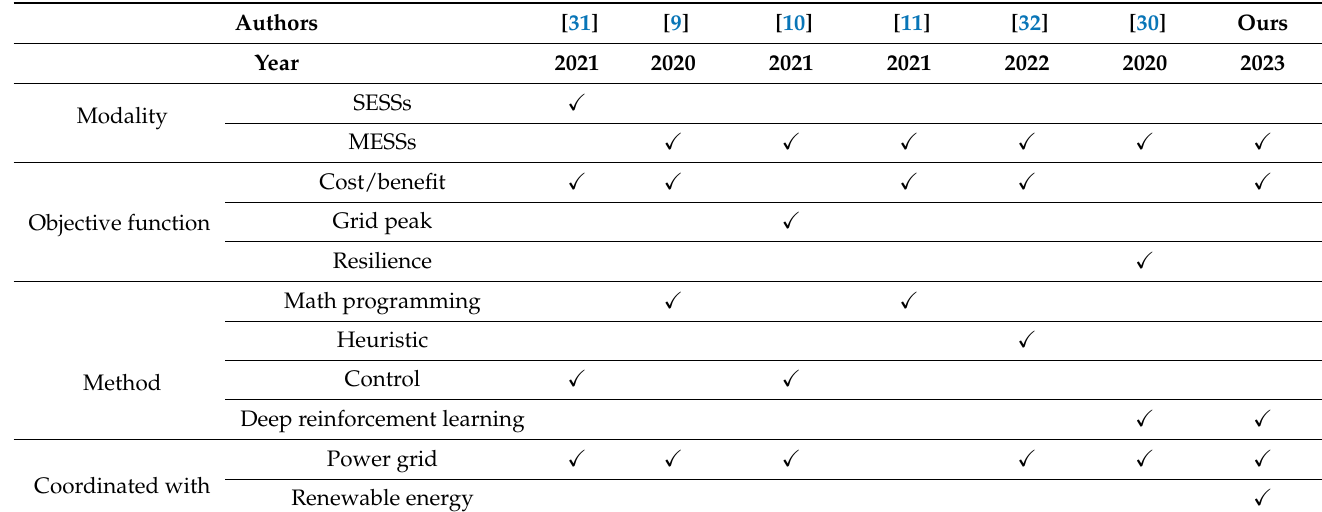
Table 1. Summary of energy management problem and power